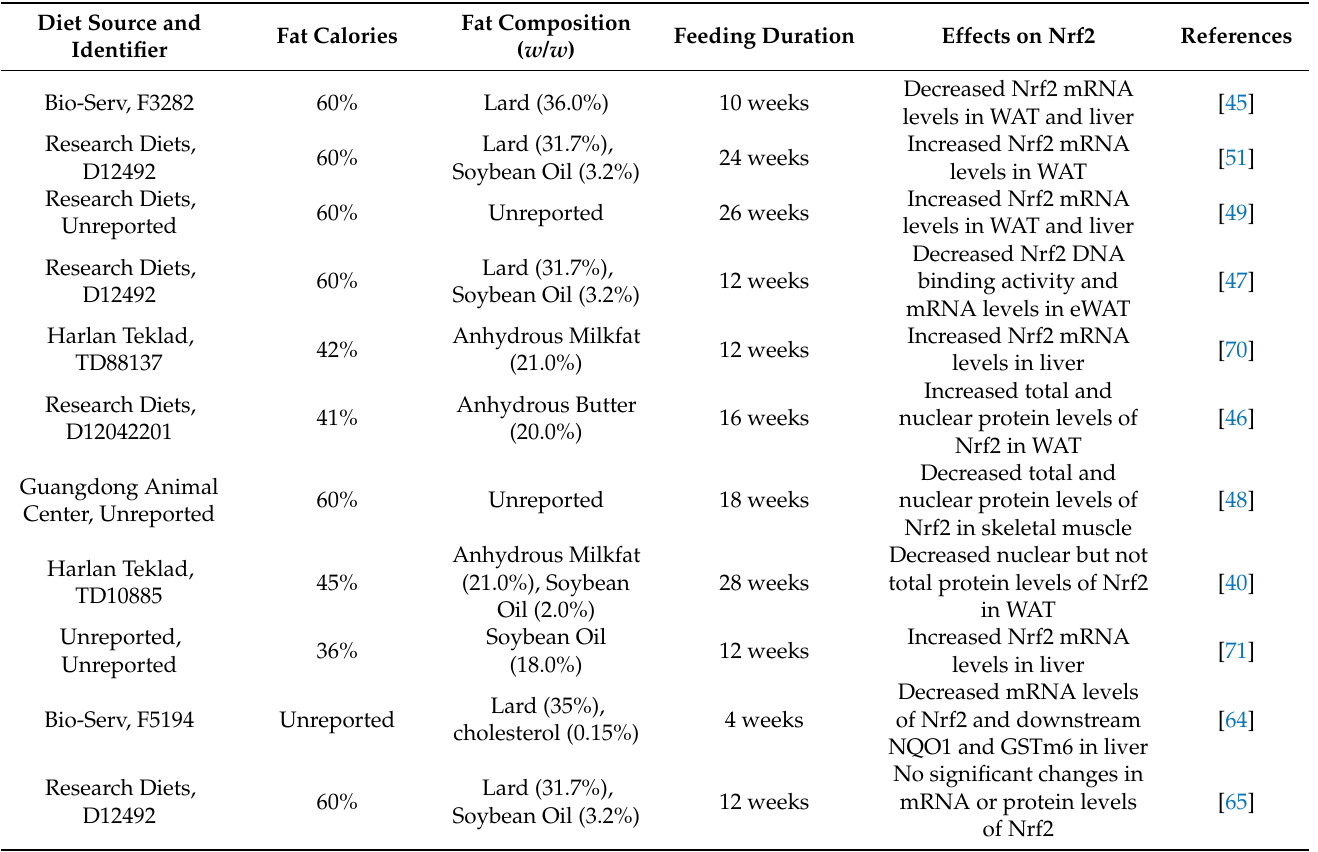
Table 2. Influence of HFD composition (fat content) and feeding duration on Nrf2